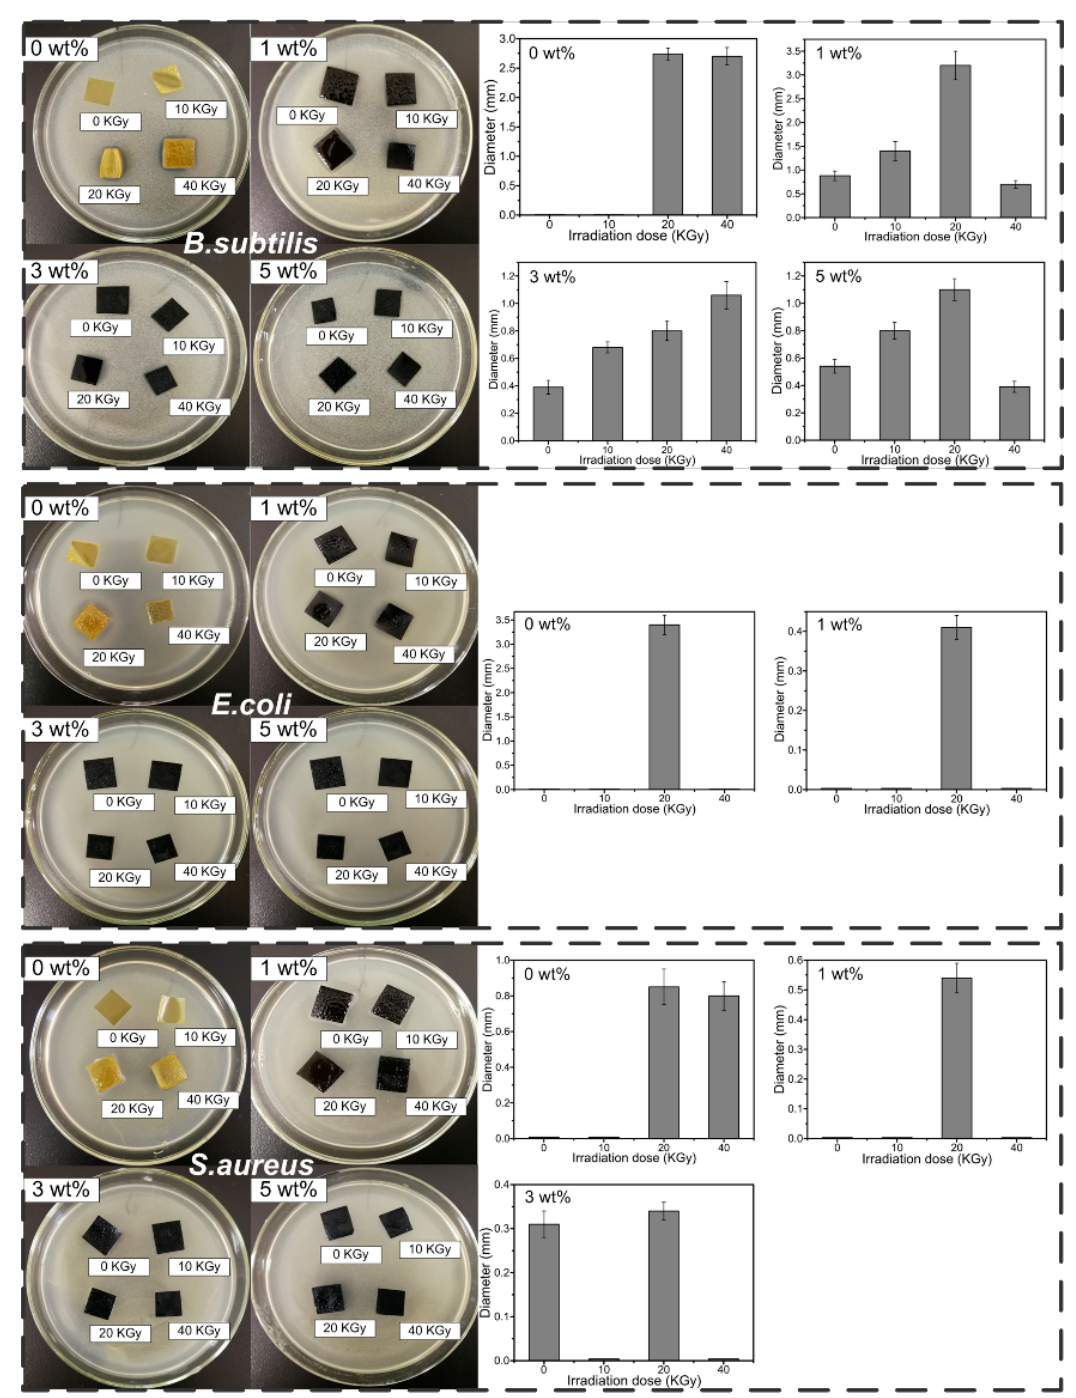
Figure 8. Inhibition zone measurement results (Photographic images and Diameter statistics of inhibition zone) of CS/GO composite films with different content of GO (0 wt %, 1 wt %, 3 wt %, and 5 wt %) under the various irradiation doses against B. subtilis , E. coli , and S. aureus .